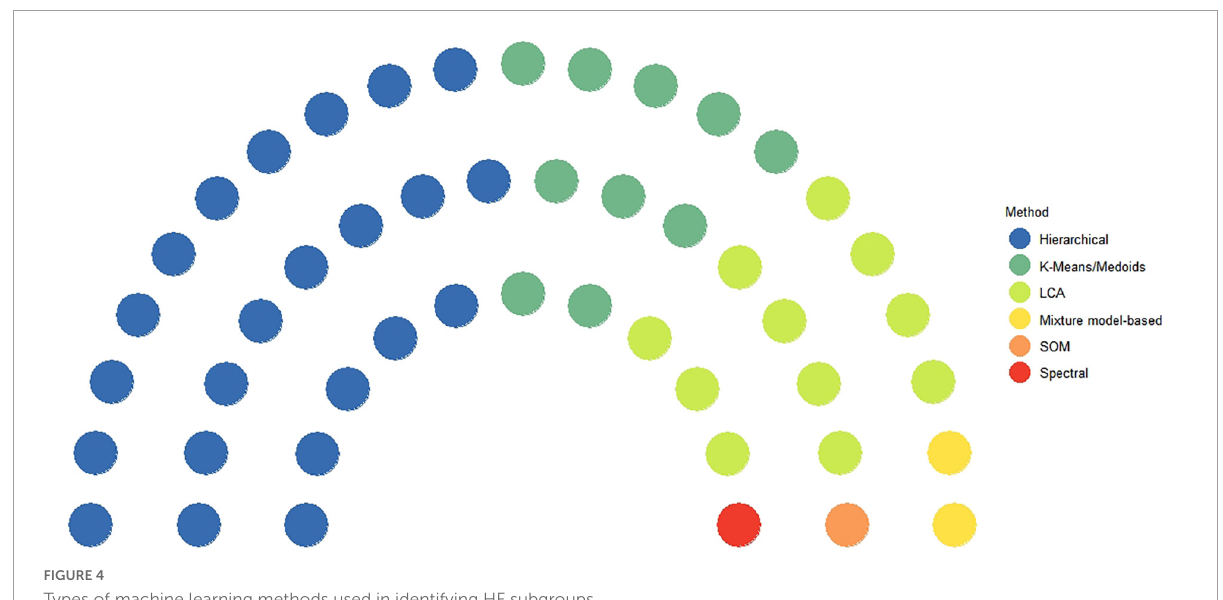
FIGURE4 Types of machine learning methods used in identifying HF subgroups.